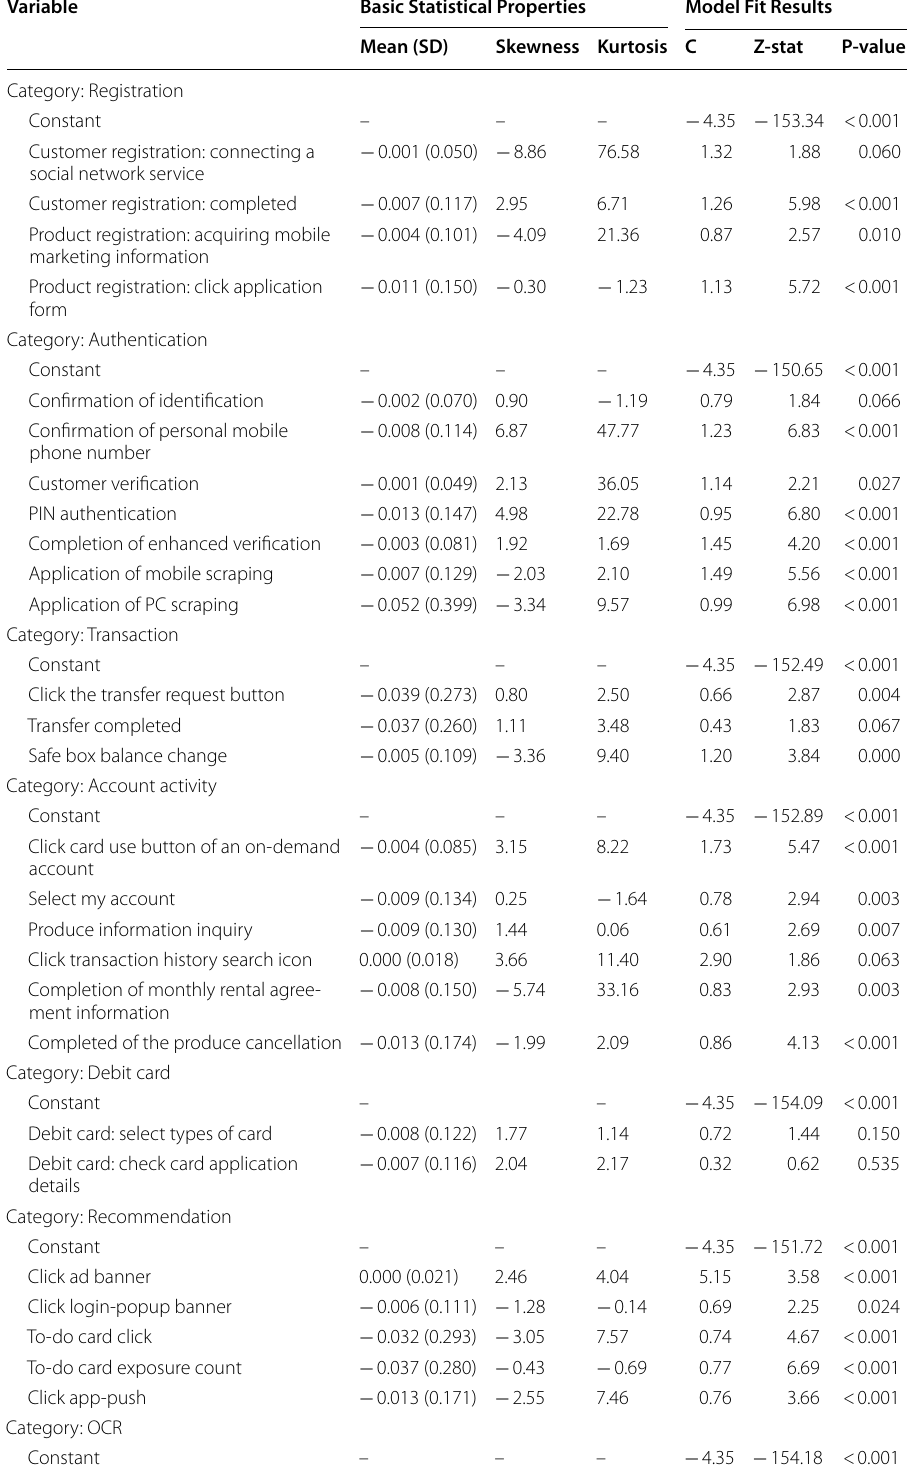
Table 2 Basic statistical properties of the features and the estimation results of the first-stage models